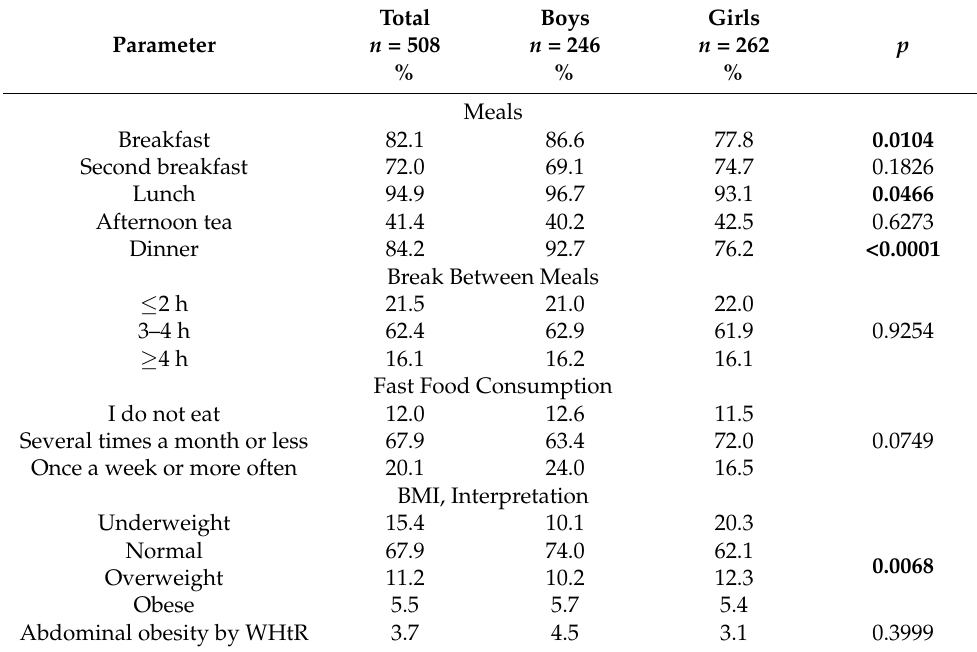
Table 1. Dietary habits and nutritional status of the study group according to